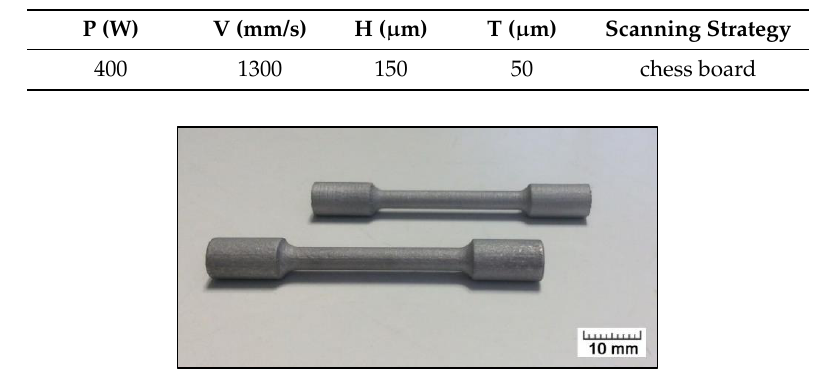
Figure 1. Tensile test samples prepared by SLM.